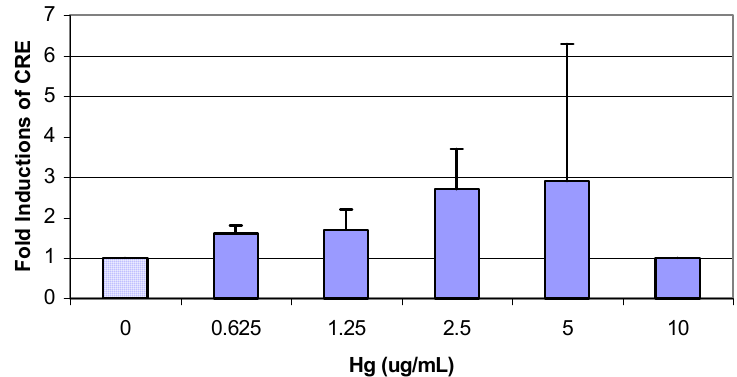
Figure 10. Fold induction of CRE in HepG2 cells exposed to mercury for 48 hours. Data represent means ± SDs, n =